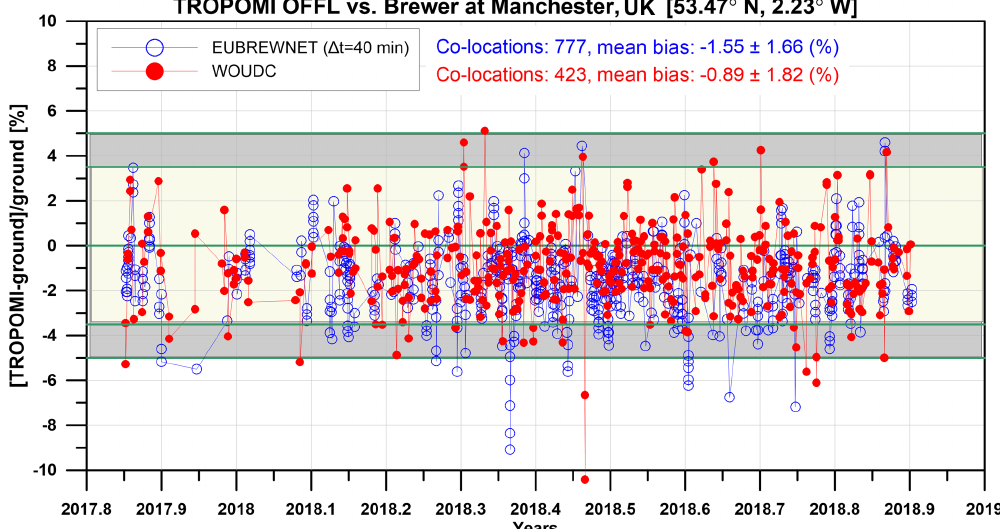
Figure 3. The time series of the comparisons between TROPOMI and GB TOC measured at Manchester, UK. Blue circles: individual GB measurements with temporal maximum difference of 40min from the TROPOMI measurements (Eubrewnet) are used. Red dots: TROPOMI compared to daily means of the GB measurements (WOUDC). Both data sets refer to the same time period.